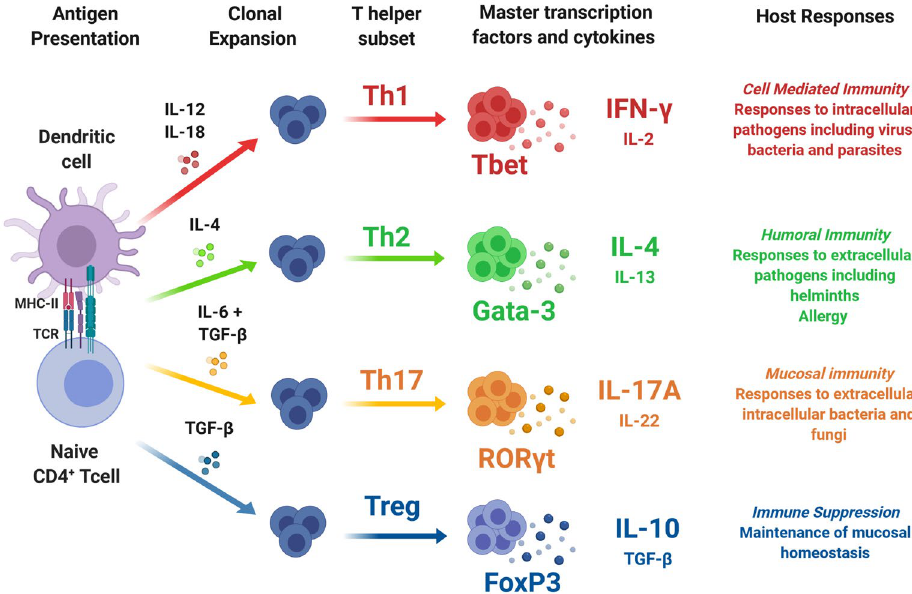
Figure 1. Overview of T helper subsets. Upon encountering foreign antigens, dendritic cells (highly specialised antigen presenting cells) process and present fragments of antigen to naïve CD4 + T cells